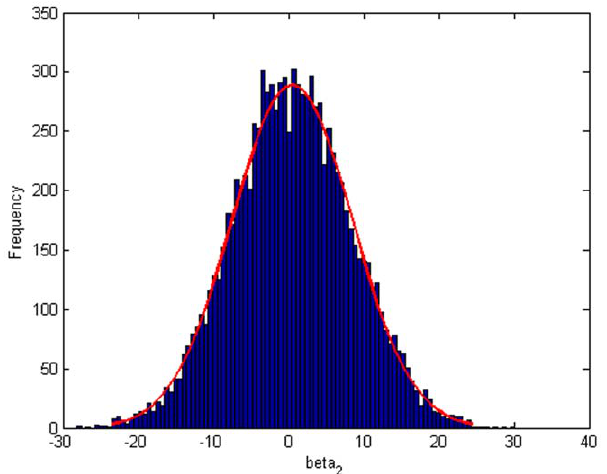
Figure 14. Normal Q-Q plot of residuals of ^ bb 1 of OLS when the variance function of the error term is s 2 ( x 1 , x 2 ) ~ exp ( { ( x 1 z x 2 ))